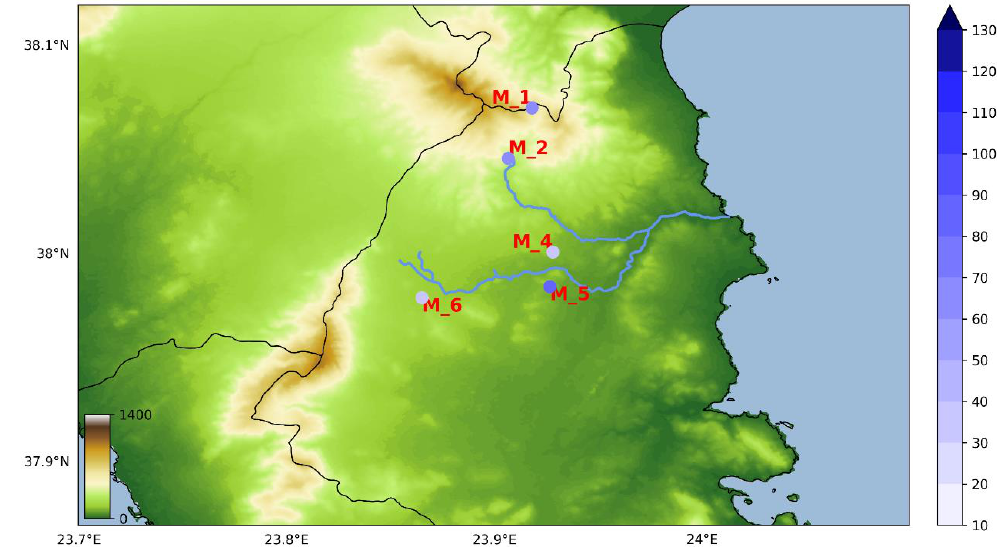
Figure 7. Topography of the study area and total accumulated rainfall observed in five meteorological stations during event #4 (10 December 2009, 2100 UTC to 11 December 2009, 0700 UTC).